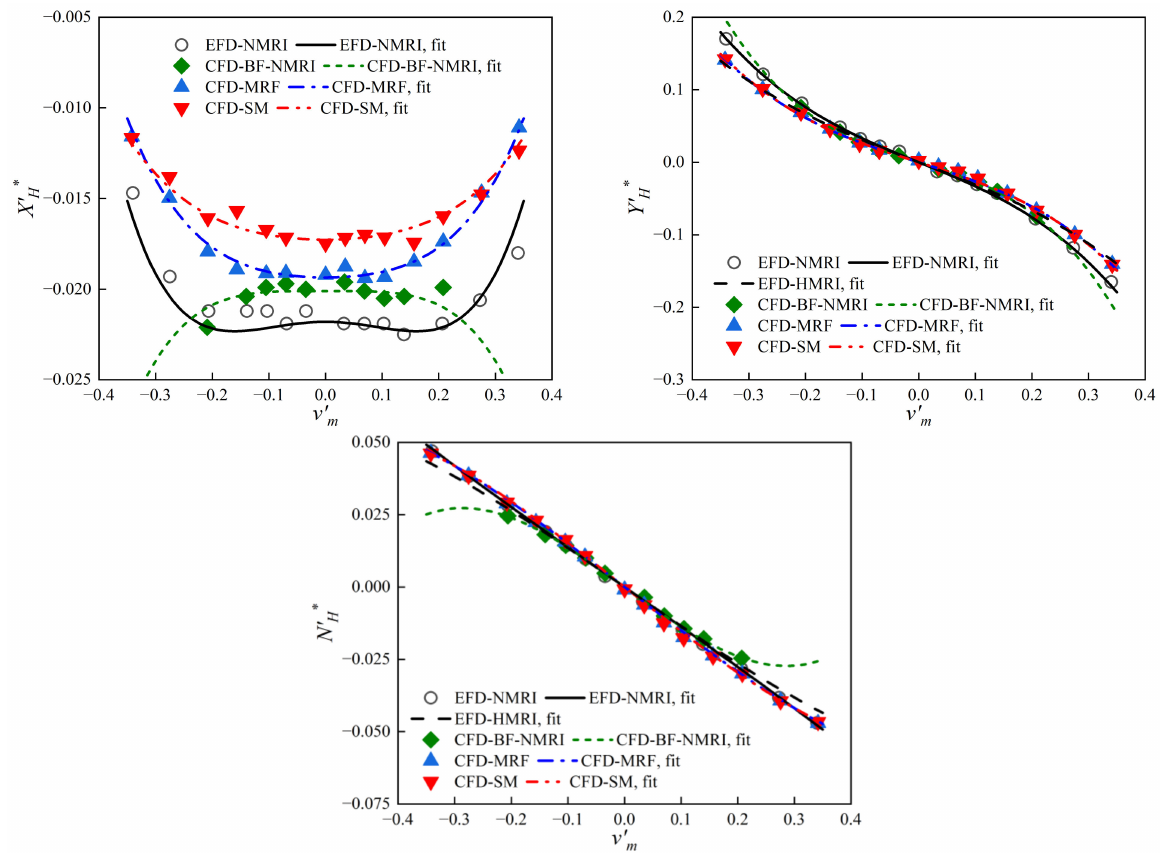
Figure 9. Hydrodynamic for es on the hull obtained from OTTs and corresponding fitting curves.